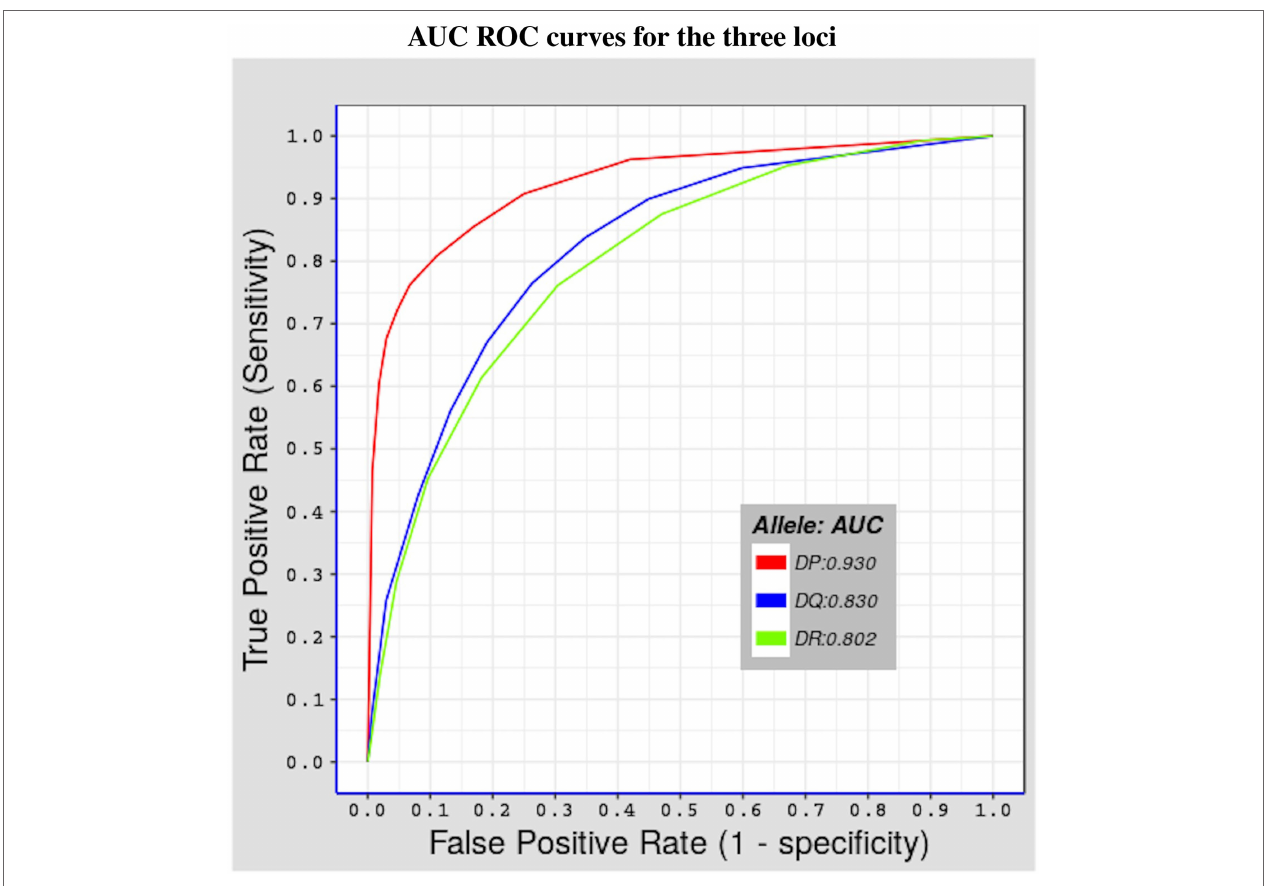
FIGURE 1 | Shows fivefold cross validation results of the model using the benchmark dataset described in Section 2.3. Three ROC curves representing the three MHC-II loci covered in this study. The red curve for HLA-DP with AUC value = 0.930, the blue curve for HLA-DQ with AUC value = 0.830, and the green curve for HLA-DR with AUC =